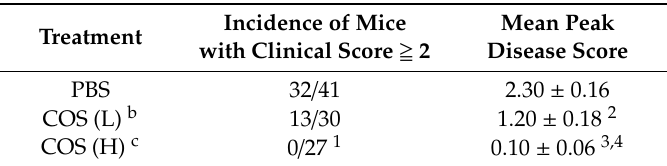
Figure 1. Chitosan oligosaccharides (COS) treatment reduces experimental autoimmune uveoretinitis (EAU) severity in mice. ( A ) Diseases scores of mice with EAU induction and treated with the high-dose (20 mg/kg) of COS ( n = 27) or low-dose (10 mg/kg) of COS ( n = 30) or phosphate-buffered saline (PBS) ( n = 41). Data show the means ± SE values (error bars). ** p < 0.01, **** p < 0.0001, compared with PBS-treated mice at the same time point. Representative photomicrographs of hematoxylin and eosin (H&E)-stained slides of the retinas of ( B ) naïve C57BL/6 mice without EAU induction, ( C ) EAU mice treated with PBS, ( D ) EAU mice treated with the low-dose (10 mg/kg) of COS and ( E ) EAU mice treated with the high-dose (20 mg/kg) of COS. * indicates retinal folds; ** indicates leukocytes in the vitreous cavity. Images are the representative results of at least four samples per group from two independent experiments. GCL, ganglion cell layer; INL, inner nuclear layer; ONL, outer nuclear layer. Table 1. E ff ects of COS treatment on EAU a